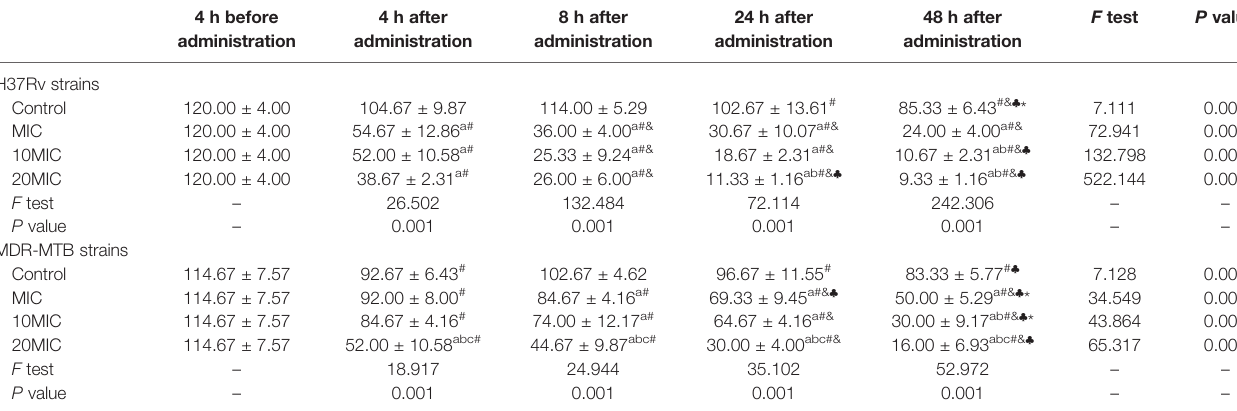
TABLE 1 | Intracellular CFU in the macrophages infected by MDR-MTB after Dlm was administered ( (cid:1) x ± s ).